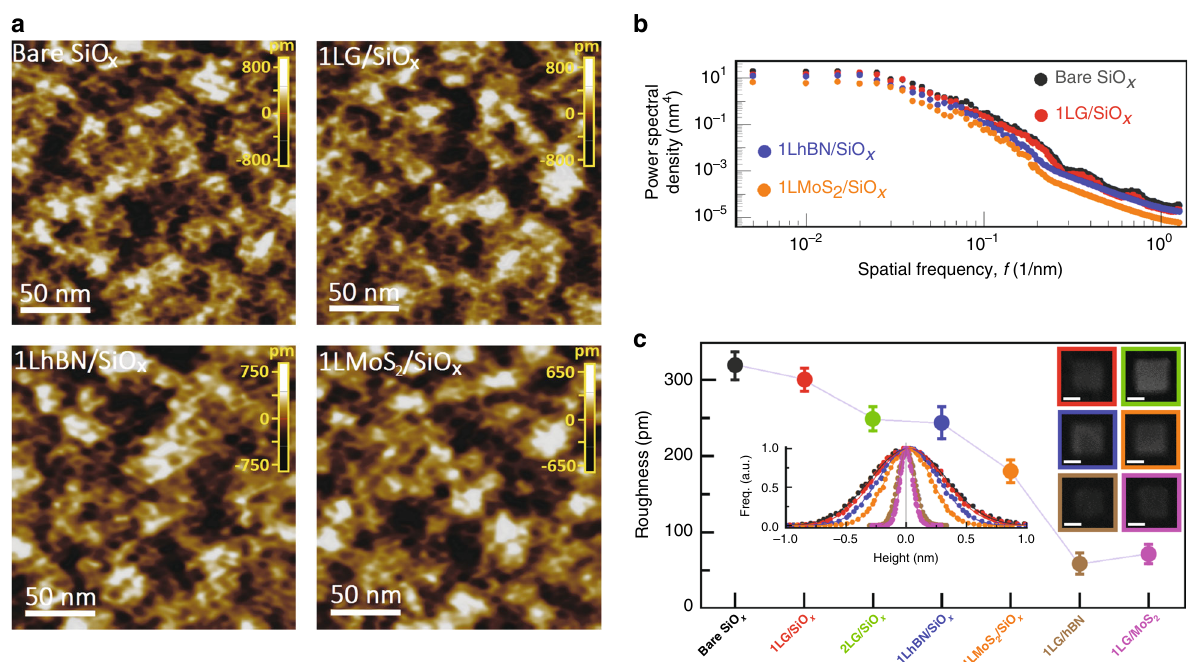
Fig. 4 Surface roughness measurements of different heterostructures. a High-resolution AFM images of the surface roughness of bare SiO x , monolayer graphene (1LG), monolayer hBN (1LhBN), and monolayer MoS 2 (1LMoS 2 ) on SiO x substrate. b PSD pro fi les corresponding to the images in a . c Surface roughness measurements of different heterostructures. Error bars show the spread of data over several independent measurements of different fl akes. Left inset: histogram of the height distribution (surface roughness) for bare SiO x , 1LG/SiO x , 1LhBN/SiO x , 1LMoS 2 /SiO x , 1LG/hBN, and 1LG/MoS 2 substrates. Solid lines are Gaussian fi ts to the distribution. Right inset: representative SEM images of 2D crystal square mesas exfoliated onto the substrate. Scale bar in each is 5 μ m. b , c and the insets of c share the same color